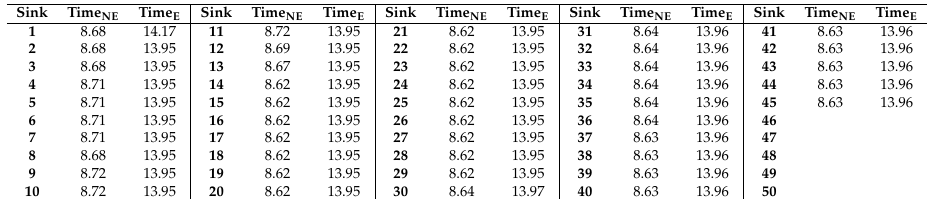
Table A7. Scenario 2: transmission times (in s) for each sink all over the transmission line. (Distance between poles is equal to 200 m, κ = 45, η = 1, NE means no encryption, E means encryption.)